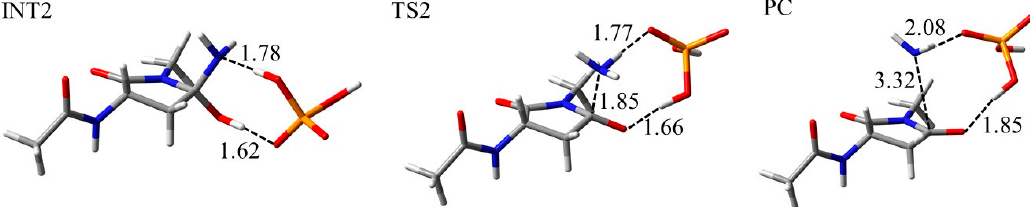
Figure 11. Optimized geometries of the deammoniation step for the anti conformation in the phosphate-catalyzed reaction. The carbon, nitrogen, oxygen, and phosphorus atoms are illustrated in gray, blue, red, and orange, respectively. Selected interatomic distances are in units of Å.